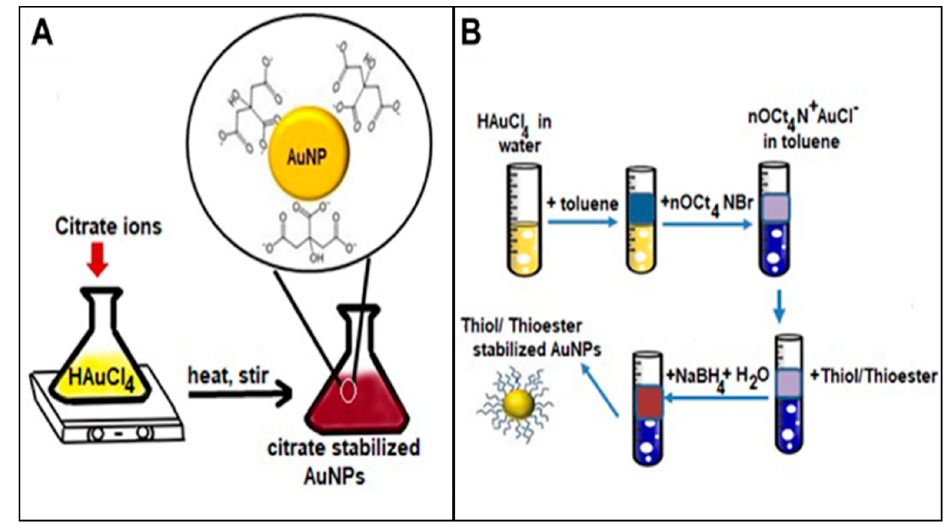
Figure 3. Synthesis of functionalized gold nanoparticles. ( A ) Turkevich method, citrate stabilized. ( B ) Burst method, thioester stabilized. (Reproduced from Ref. [13] with permission from author.)